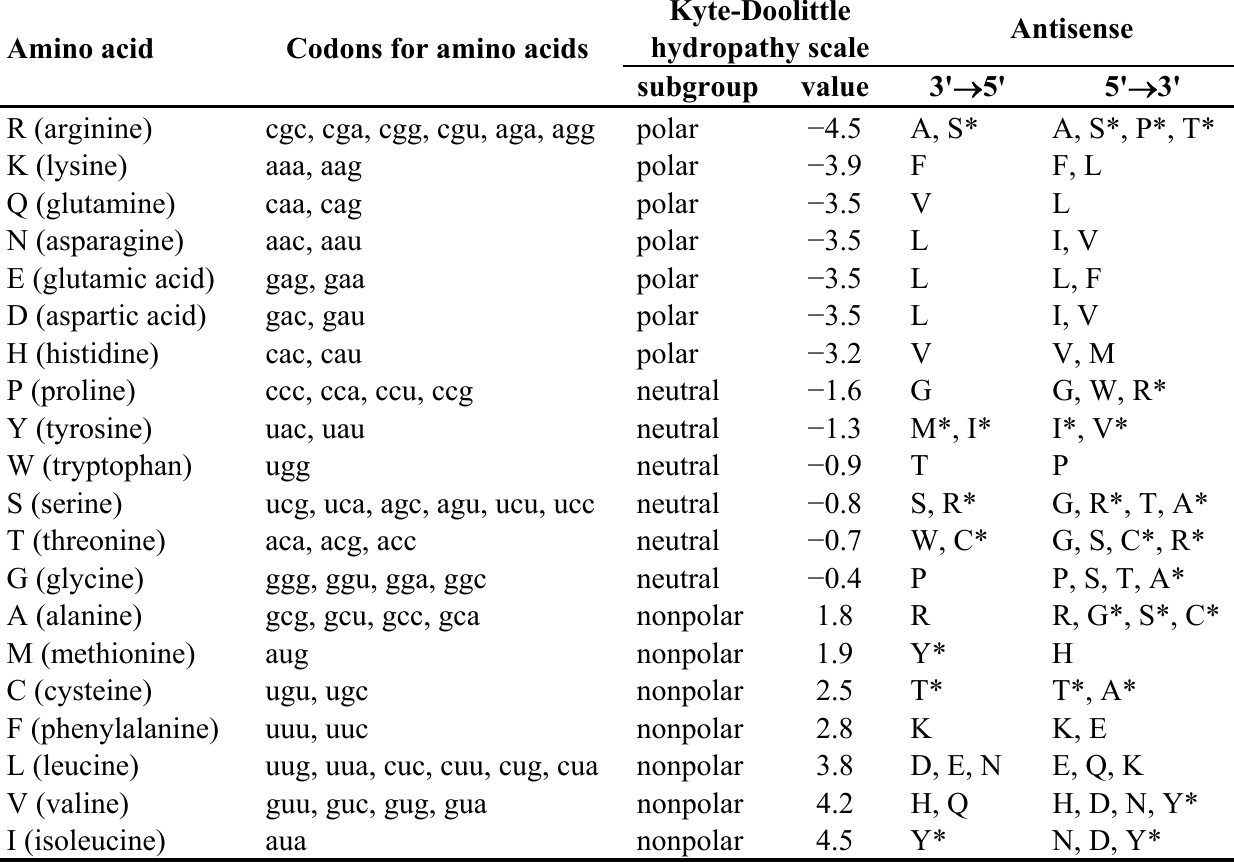
* Deviations from polarity patterns in Molecular Recognition